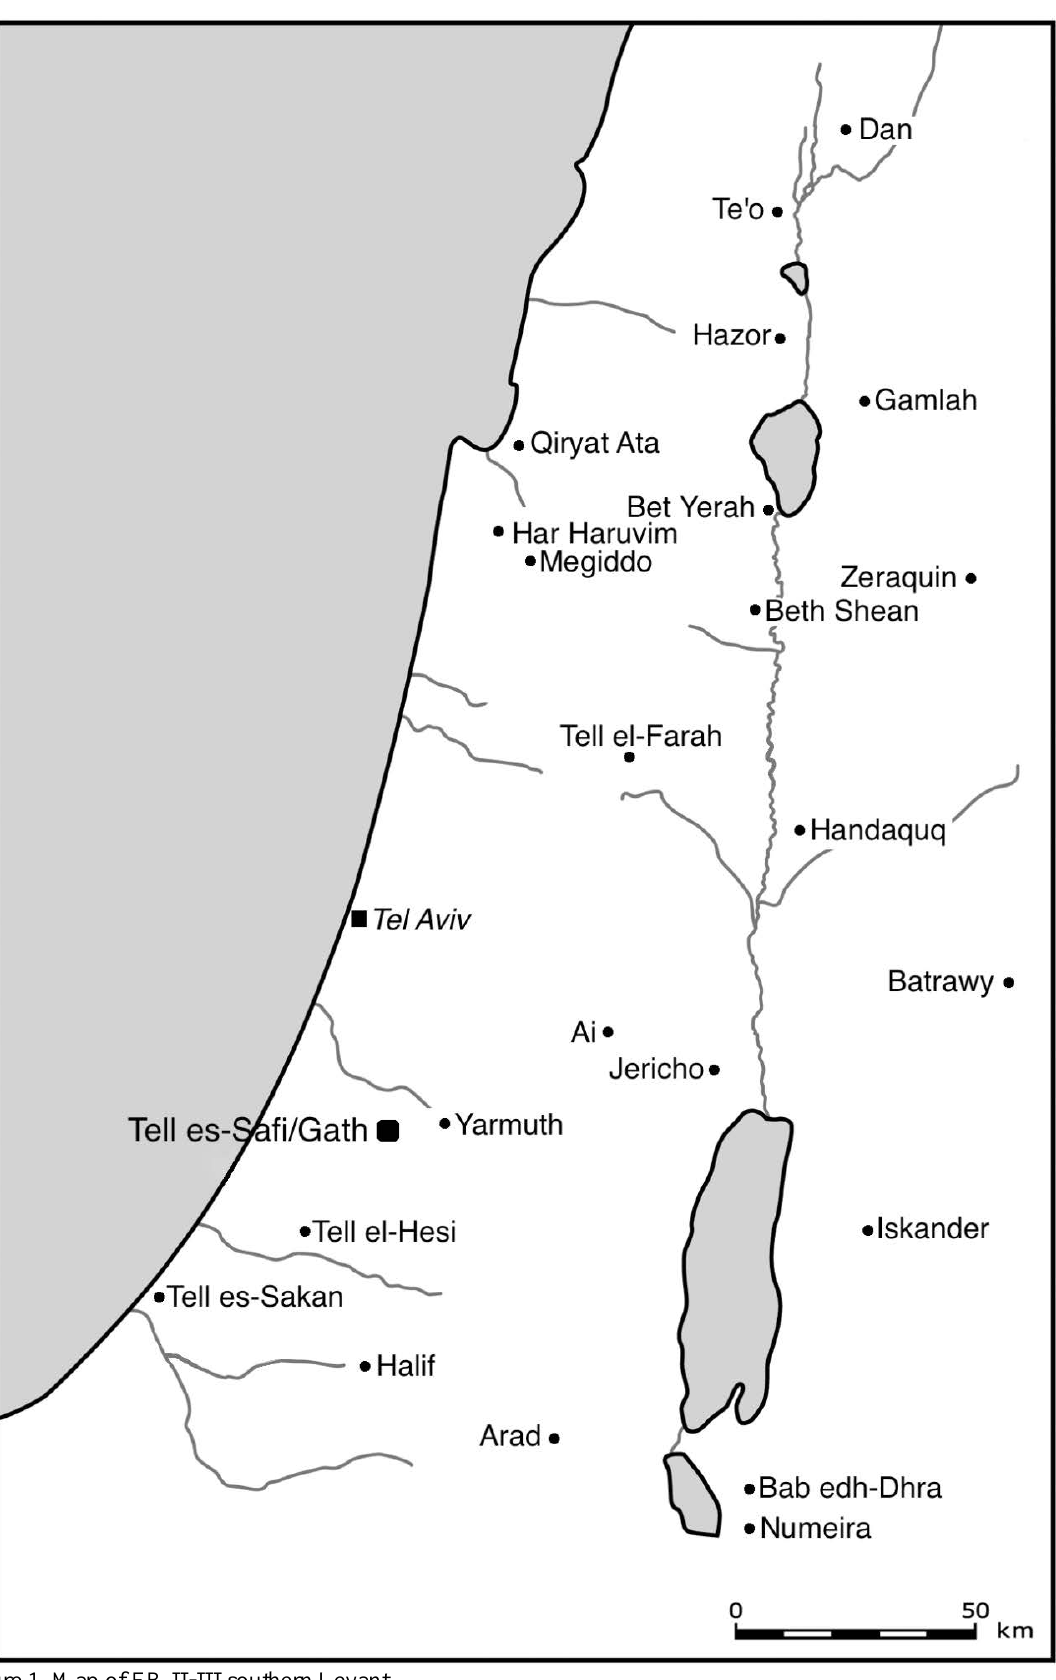
Figure 1. Map of EB II-III southern